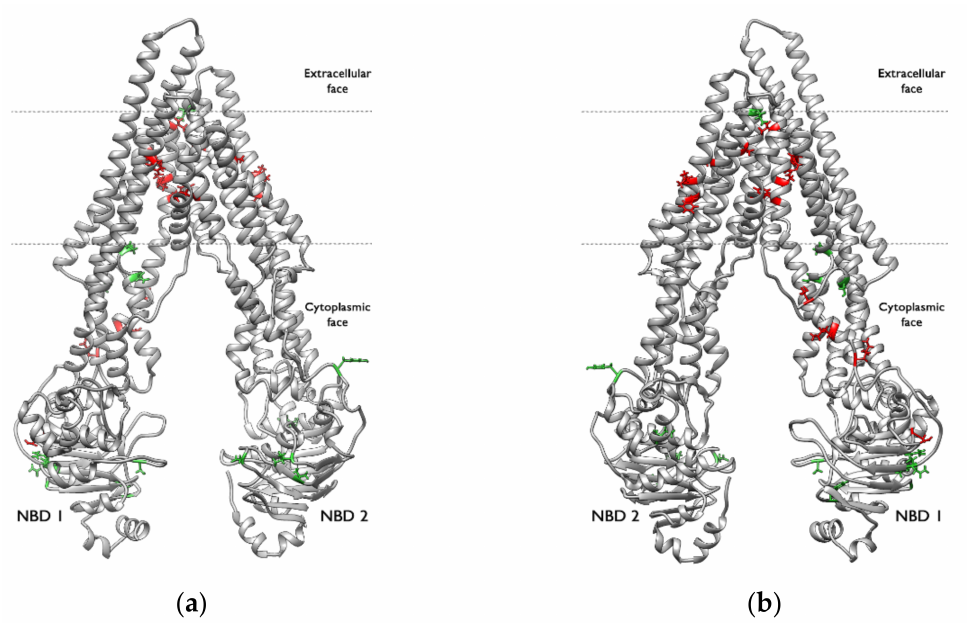
Figure 15. P-Glycoprotein residues with significant variations in the solvent-accessible surface area (SASA): ( a ) front view and ( b ) back view. The residues coloured red have a smaller SASA in the systems formed by P-gp and an active compound. The residues coloured green have a larger SASA in the systems formed by P-gp and an active